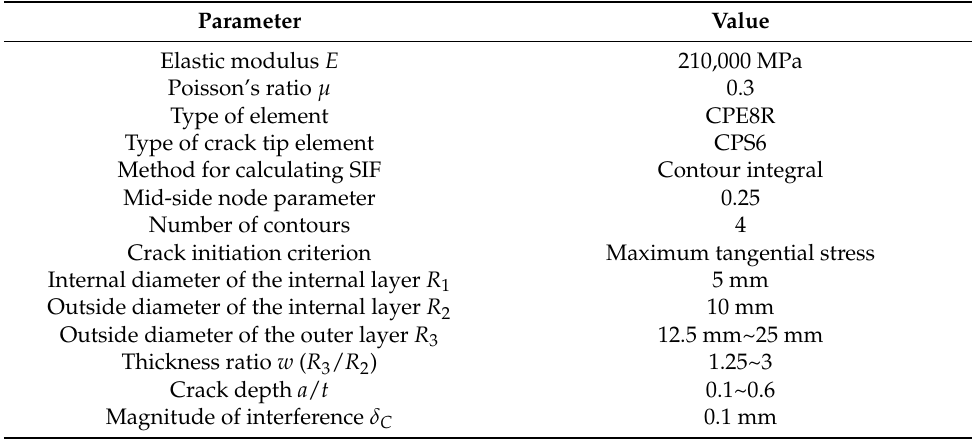
Figure 2. Finite element model with a crack. Table 1. Parameters of finite element model.